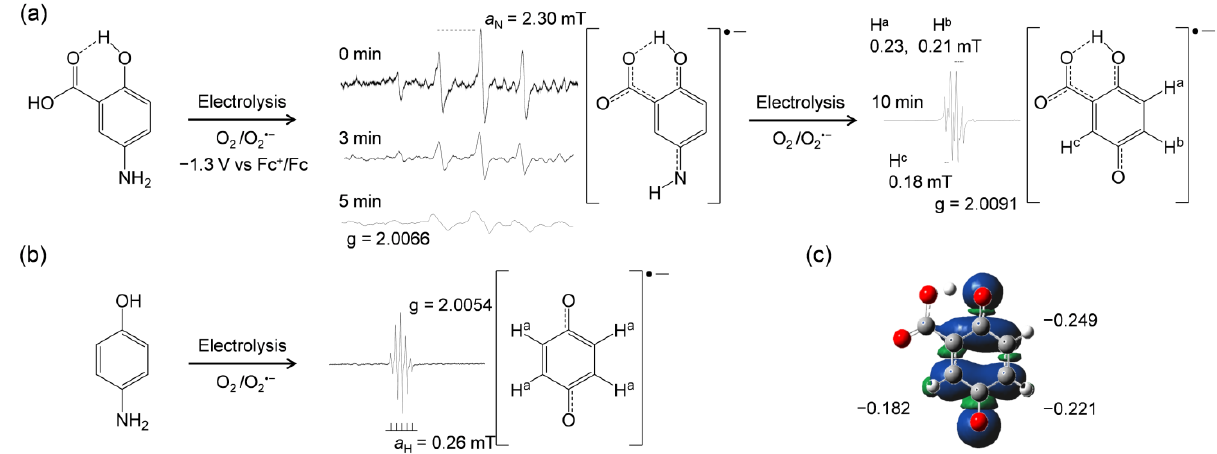
Figure 4. Electrolytic electron spin resonance (ESR) spectra for O 2 (4.8 × 10 –3 mol dm –3 ) in DMF solutions in the presence of 5-ASA ( a ), and p -AP ( b ) at 5.0 × 10 − 3 mol dm − 3 as obtained by in situ controlled-potential electrolysis of solutions containing 0.1 mol dm − 3 TPAP at an applied potential of − 1.3 V vs. Fc + /Fc. The in situ ESR measurements were performed by 3 min scans 0, 3, 5, and 10 min after application of the potential began. Radical structures with the g-values and the appropriate hyperfine coupling constants (HFCCs) (mT) for nitrogen ( a N ) and hydrogen ( a H ) were obtained by simulation based on the measured spectra. The spin distribution for the 1,4-benzoquinone-2-carboxylic acid radical anion was calculated by density functional theory (DFT) at the B3LYP/PCM/6-311+G(d,p) level ( c ), and charge distributions for the 1-, 2-, and 5-position carbons were derived by natural bond orbital (NBO) analysis.